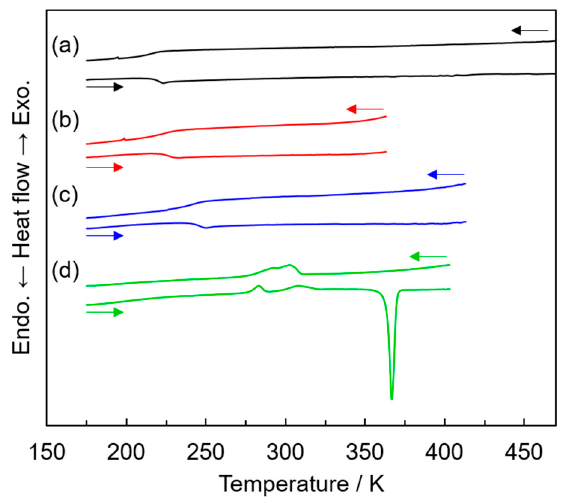
Figure 2. Differential scanning calorimetry curves of the 1-allyl-1-(oxiran-2-ylmethyl)piperidinium- based organic salts: ( a ) 1 , ( b ) 2 , ( c ) 3 , and ( d ) 4 . Table 1. Physicochemical properties of the 1-allyl-1-(oxiran-2-ylmethyl)piperidinium-based organic salts at 298 K.